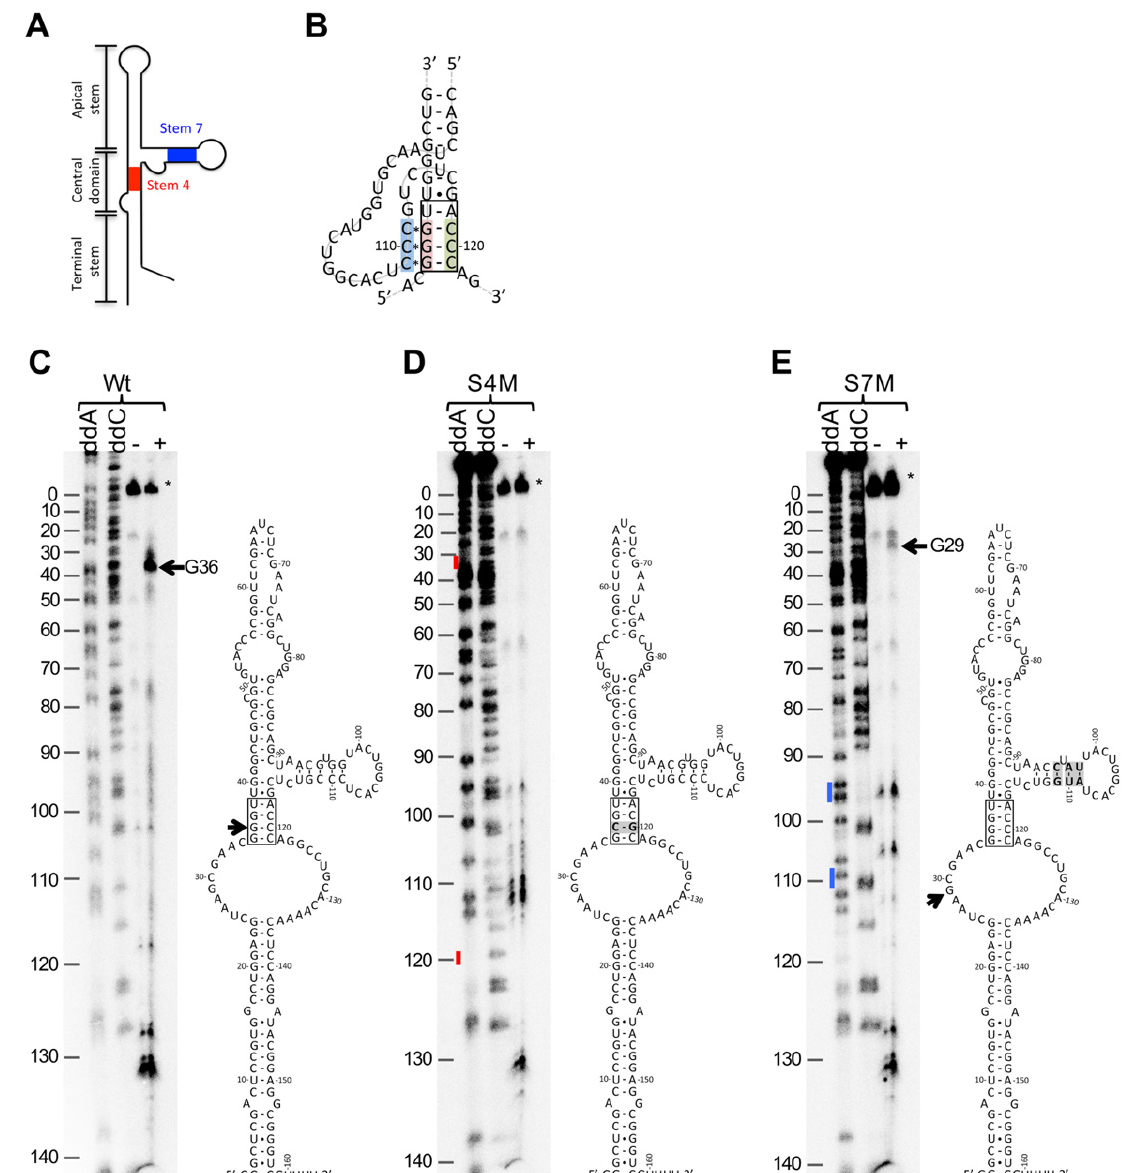
Figure 2. BQQ–OP cleavage specificity of the HAdV-4 VA-RNAI. ( A ) Schematic illustration of the HAdV VA RNAI structure. ( B ) Schematic illustration of a potential HAdV-4 VA RNAI triplex formation between the stem 4 and stem 7 sequences. Dashes (-) represent Watson–Crick base-pairing, whereas asterisks (*) represent Hoogsteen base-pairing. ( C ) BQQ–OP cleavage pattern of HAdV-4 VA RNAI (Wt). ( D ) BQQ–OP cleavage pattern of HAdV-4 VA RNAI (S4M). ( E ) BQQ–OP cleavage pattern of HAdV-4 VA RNAI (S7M). The hyphen (-) indicates incubation in the absence of BQQ–OP, whereas the plus (+) shows incubation in the presence of BQQ–OP. Horizontal arrows point towards specific VA RNAI cleavage products. The asterisk (*) marks the full-length, uncleaved VA RNAI. Sanger sequencing reactions with dideoxynucleotides (ddC and ddA) on HAdV-4 VA RNAI (Wt, S4M, S7M) containing plasmids were used for VA RNAI nucleotide numbering from 5 ′ to 3 ′ . Stem 4 and stem 7 sequences are indicated by red and blue colors, respectively.